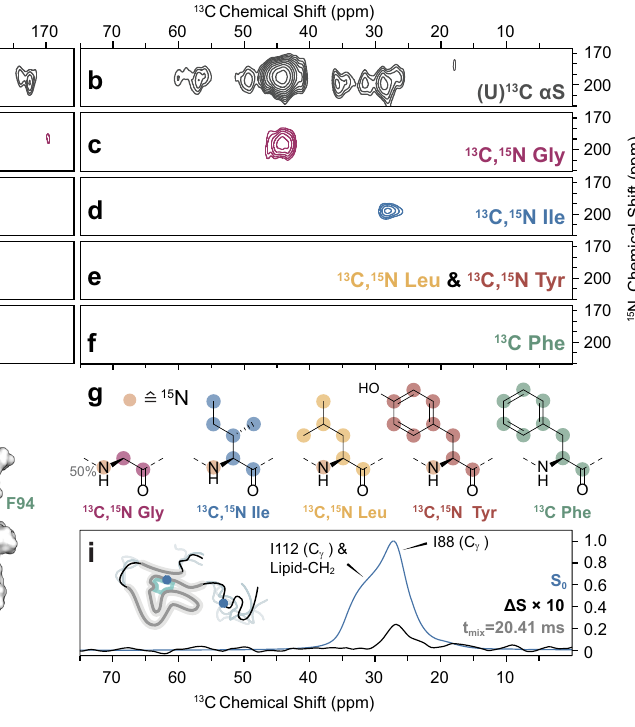
Fig. 1 | Identi fi cation of anle138b binding inside α -synuclein fi brils by DNP- enhanced MAS NMR. a Isotope labeling strategy used for the preparation of fi bril samples for studies by DNP-enhanced MAS NMR. 13 C-labeling of amino acids indi- catedbycoloredcircles:unifom-(gray),Gly-(magenta),Ile-(blue),Leu-(yellow),Tyr- (red), and Phe-labeling (green). 15 N-labeling on anle138b indicated by orange circles.